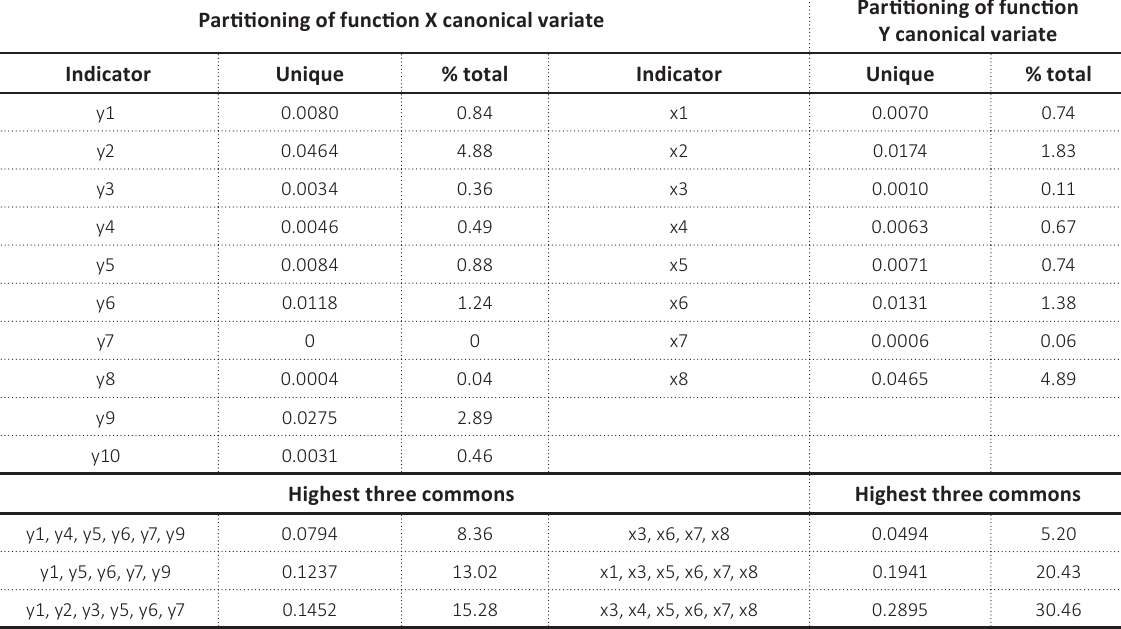
Table 11. Partitioning of the variances of canonical variates to unique and common effects based on commonality analysis Partitioning of function X canonical